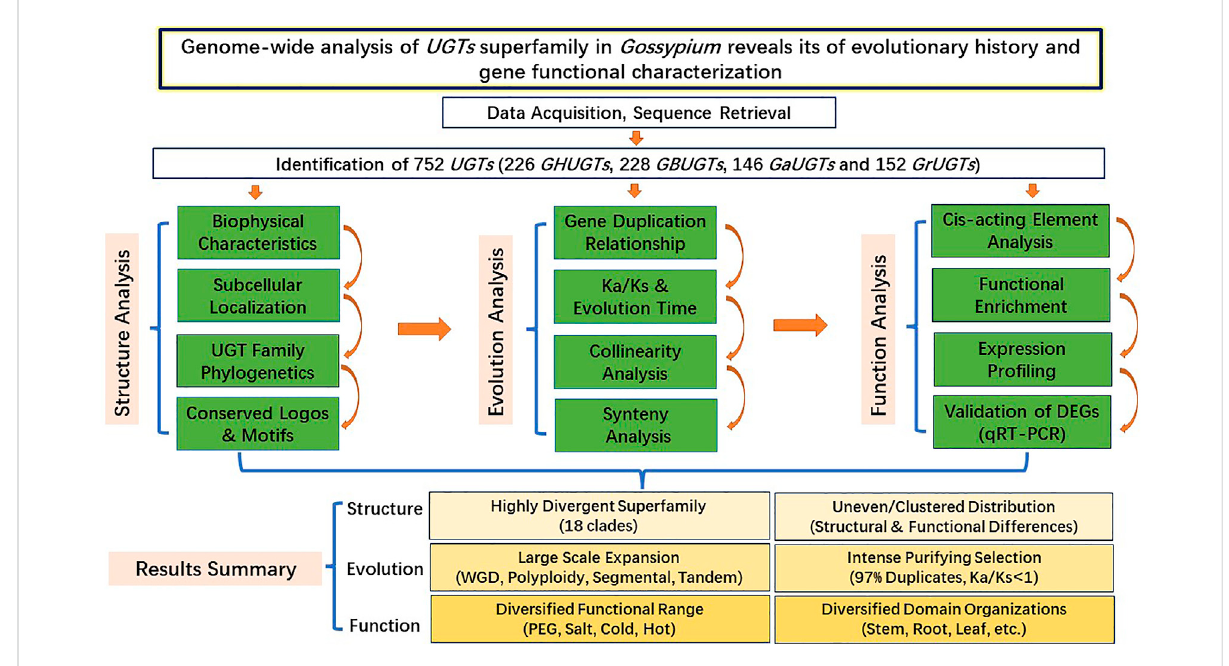
FIGURE 14 Systematic analysis diagram of UGT gene family structure, evolution and